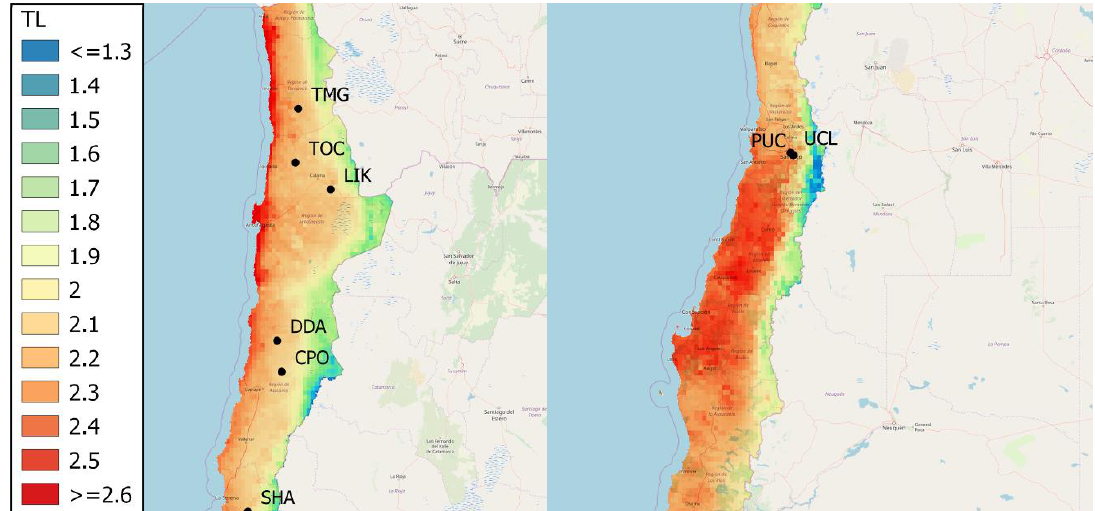
Figure 13. Estimated Linke turbidity for the Chilean territory on 2 July 2019.